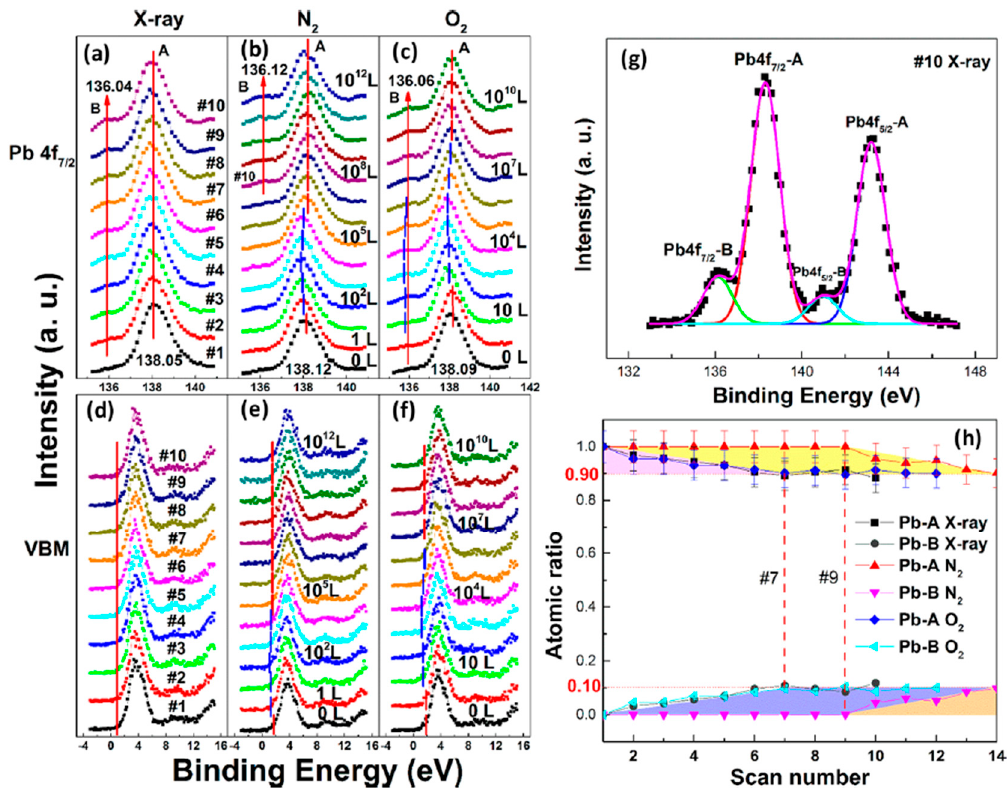
Figure 6. ( a – f ) XPS spectral evolutions of Pb 4f7/2 and VBM of cleaved MAPbBr3 single crystal under X-ray, N2, and O2 exposures, respectively. ( g ) The detailed fitting curves for Pb under the 10th X-ray scan. ( h ) Elemental ratio comparisons of Pb peaks under the three conditions with error bars. From Ref. [38] with permission.